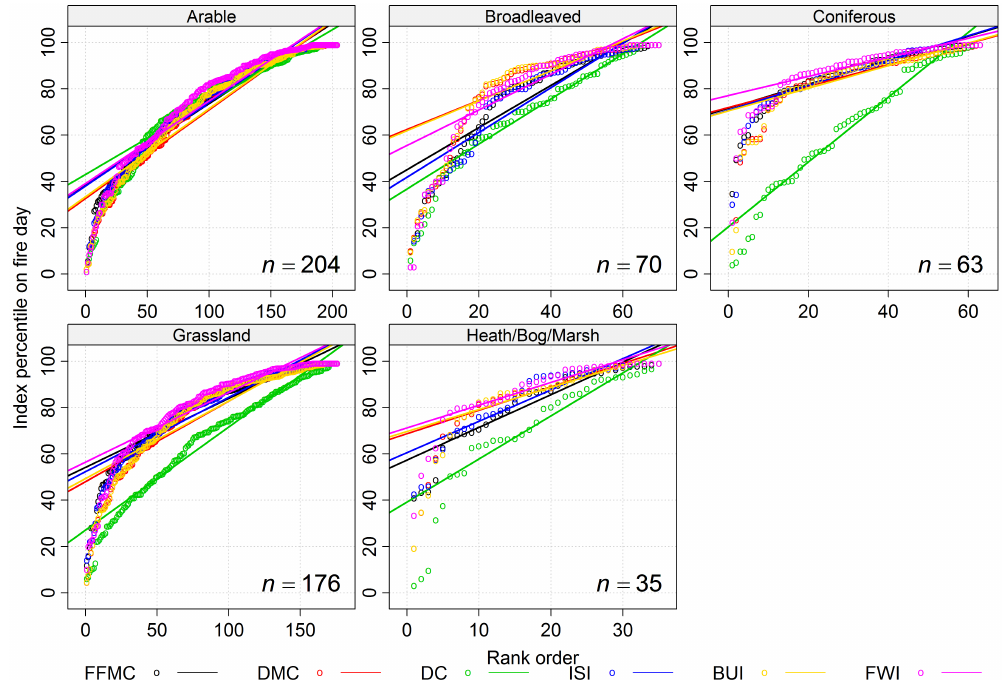
Figure 10. Ranked percentile curves (after Eastaugh et al.’s (2012) approach) of NWP forecast-derived Fire Weather Index components during all summer wildfire events recorded in the Incident Recording System (IRS) of the Fire and Rescue Service between January 2010 and December 2012 in Great Britain, split by dominant land cover type. See Fig. 1 for how to interpret these curves. For each wildfire event, the maximum daily FWI component percentile calculated over the duration of the event was extracted from the NWP grid cell in which the fire occurred. For each season and FWI component, the percentiles of each fire event were plotted in ascending rank order, and regression lines fit using the Theil–Sen method (Theil, 1950a, b, c; Sen, 1968) – a median-based model that is minimally influenced by outliers (see Sect. 4.3.2). The greater the intercept value and smaller the slope value of a model fit, the more skilful the FWI component is in terms of predicting severe wildfire behaviour. In the summer months the FWI component has the greatest skill grassland, heath/bog/marsh and coniferous environments, the DC has the greatest skill in arable environments and the DMC/BUI have the greatest skill in broadleaved